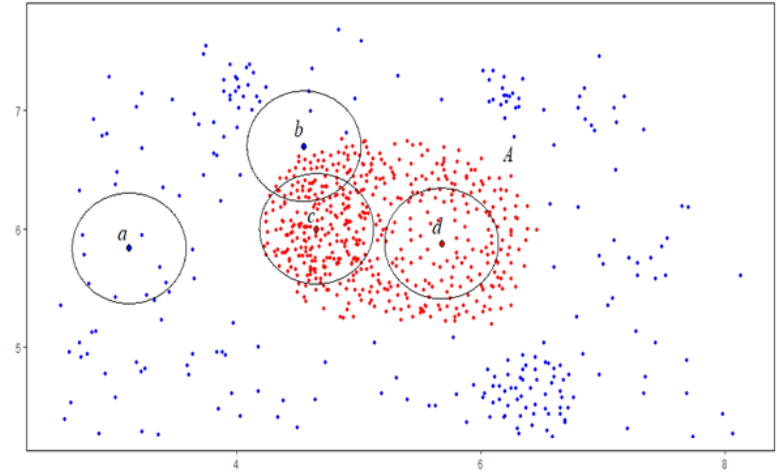
Figure 1. The concept of density relative to a set. Four points ( a , b , c , and d ) are selected in the initial array X . The density S in them relative to the subset A (red dots) is equal to the number of points from A that fall into the balls indicated in the figure. Point c will be densest with respect to A , followed by points b , d , and a